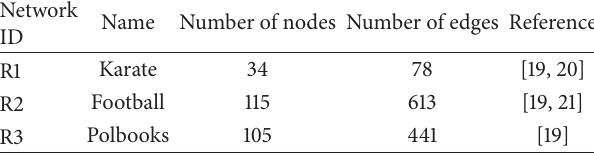
Table 2: Real network